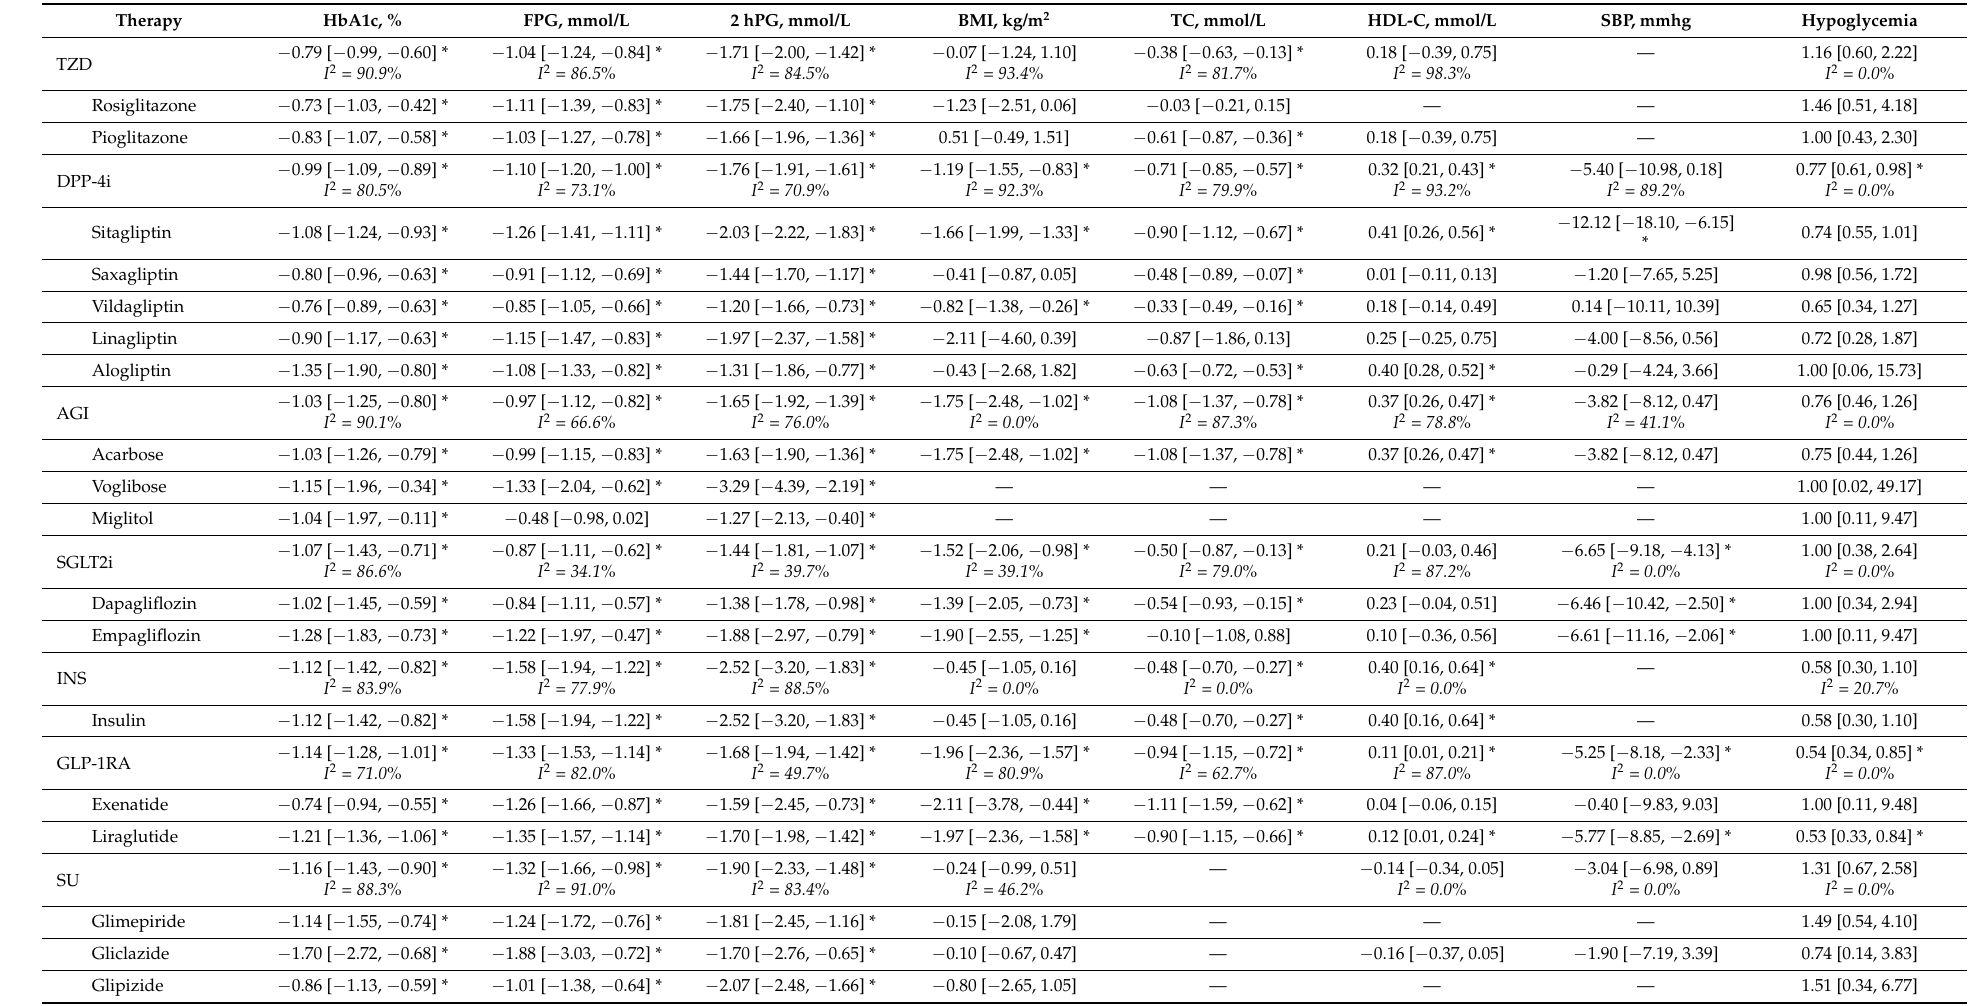
Table 1. Treatment effects of glucose-lowering drugs added to metformin compared with metformin